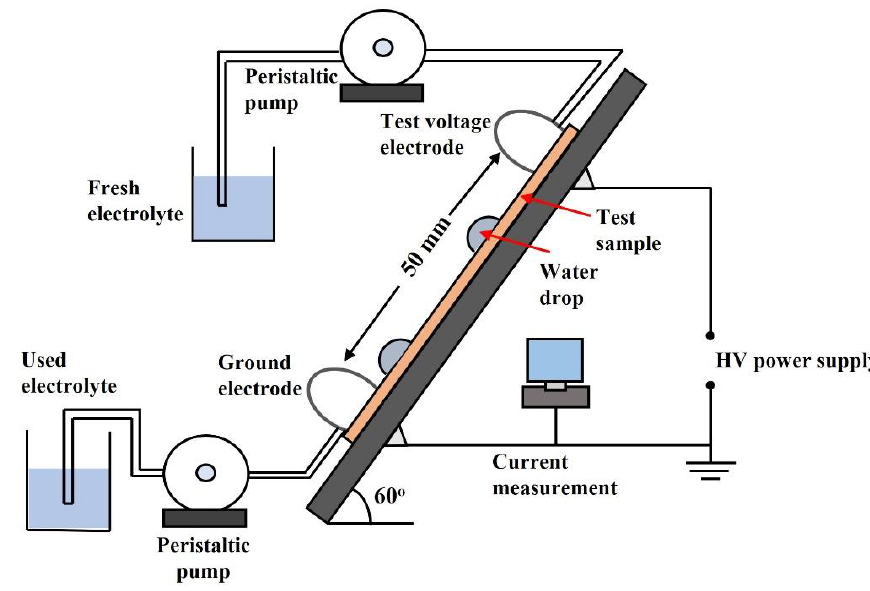
Figure 9. Schematic of dynamic drop test for evaluation of hydrophobicity recovery.